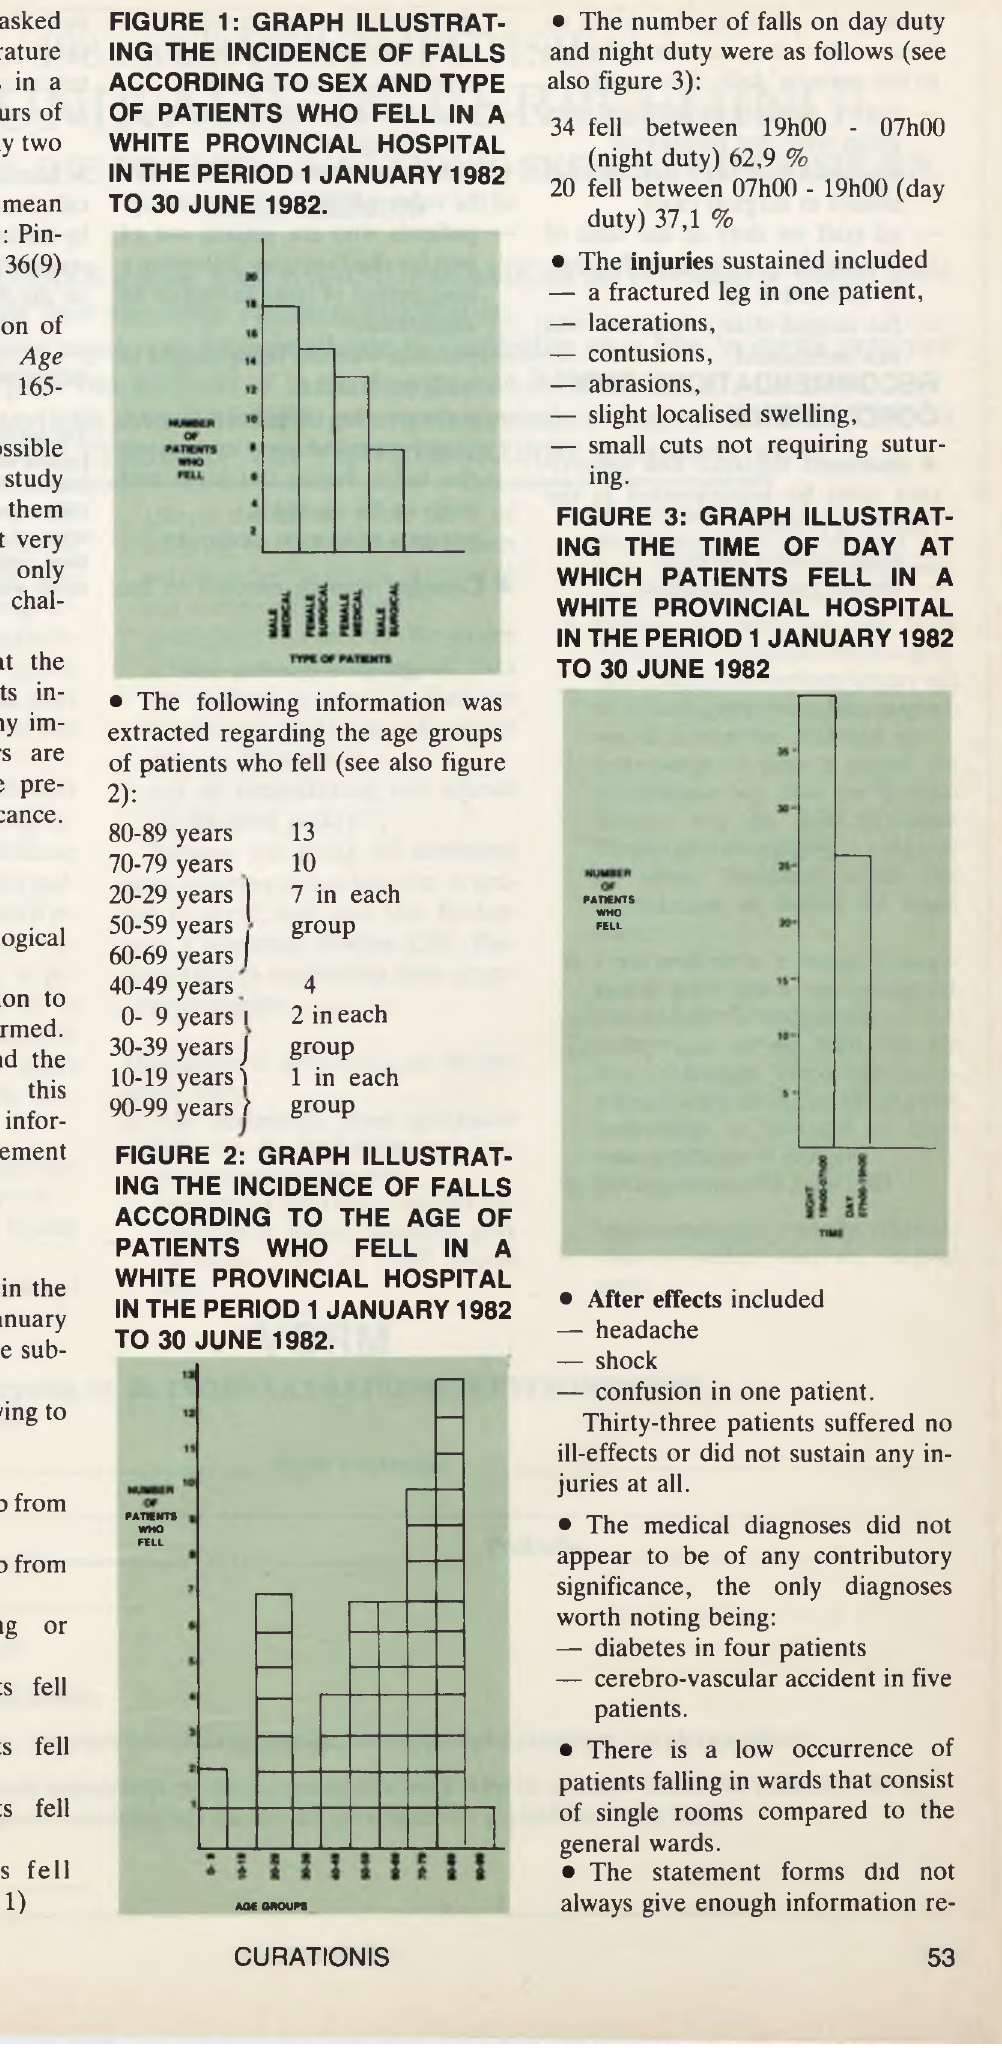
ING THE INCIDENCE OF FALLS ACCORDING TO SEX AND TYPE OF PATIENTS WHO FELL IN A